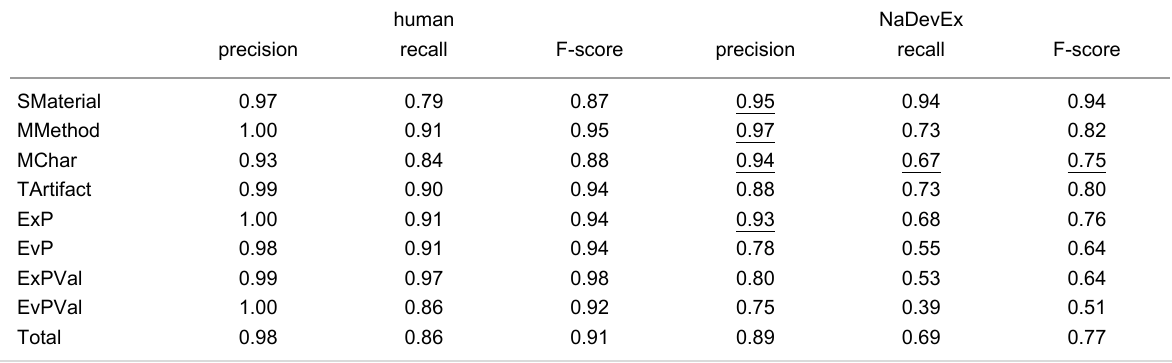
Table 2: Average performance of NaDevEx and the human annotation results compared with the annotation of the domain expert. human NaDevEx precision